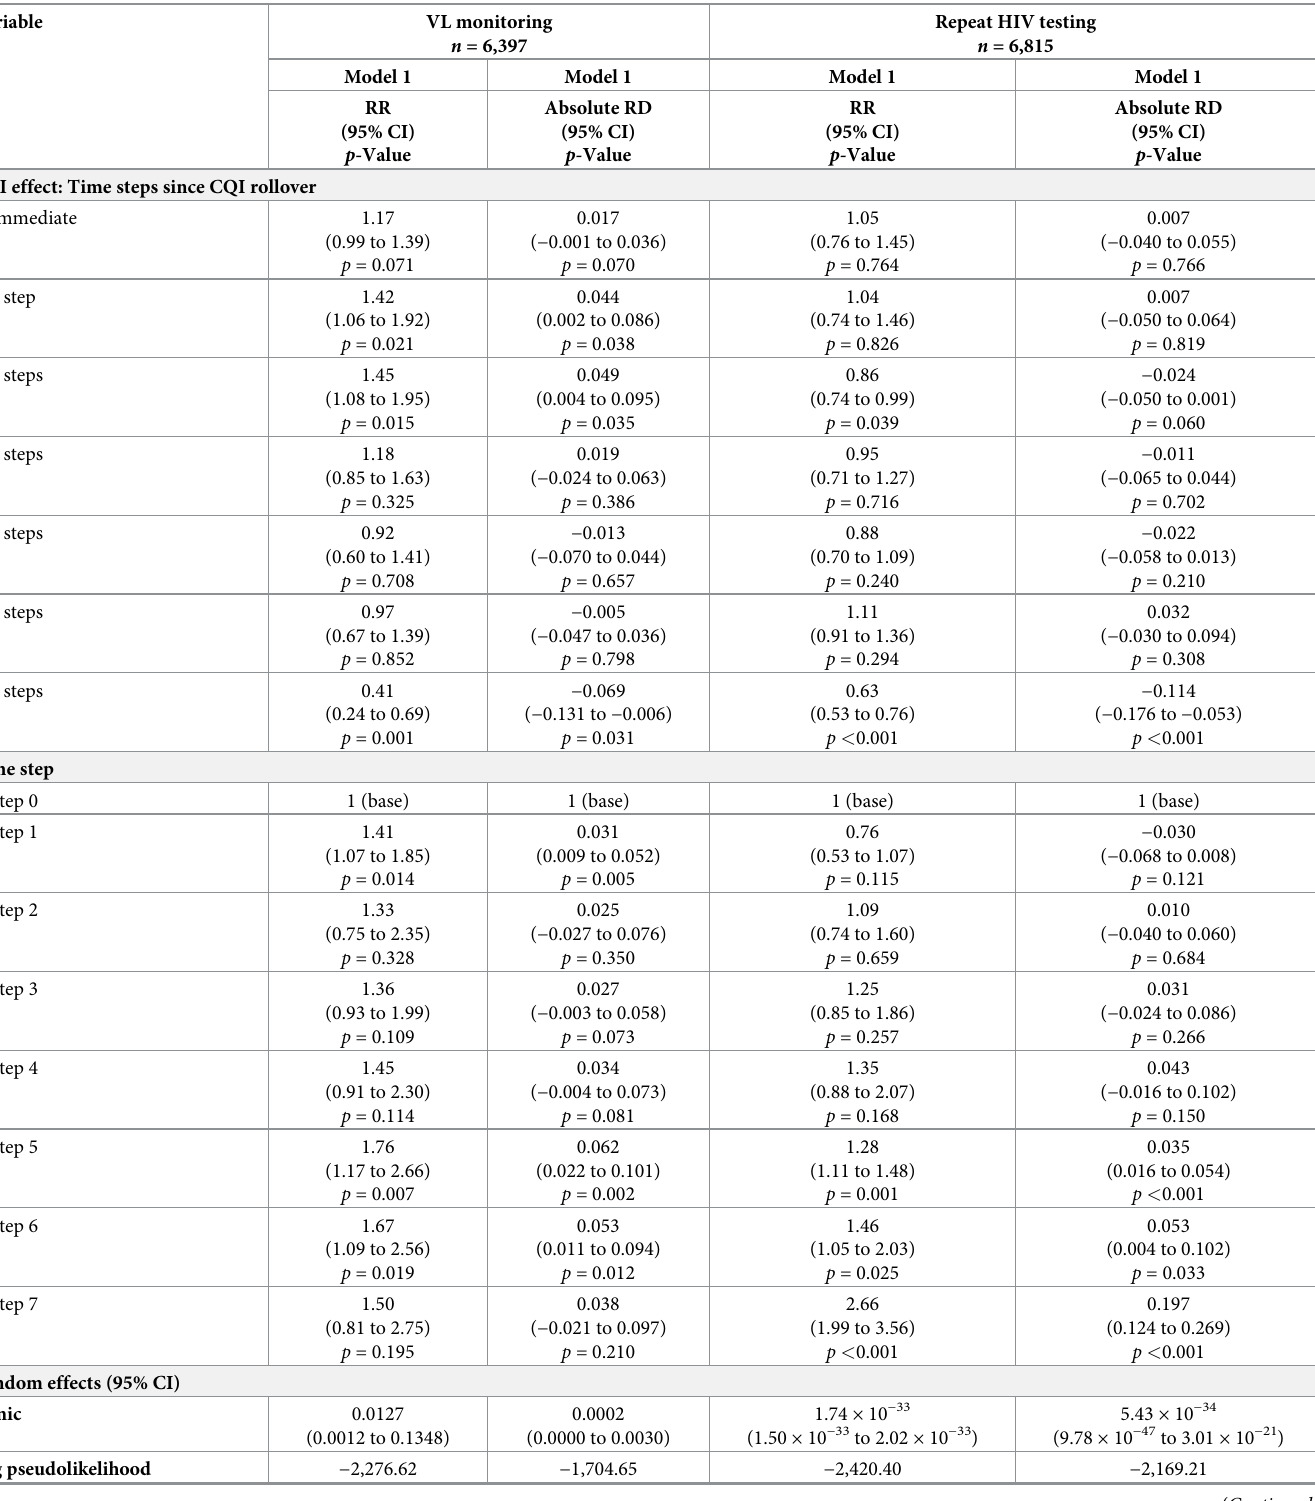
Table 6. CQI effect heterogeneity by time since rollover to